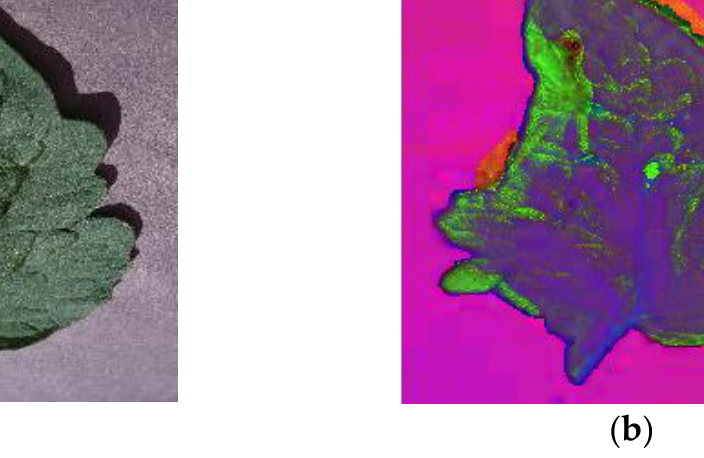
Figure 4. Representation of the processed image: ( a ) the RGB image; ( b ) the HSV image converted from the RGB image.